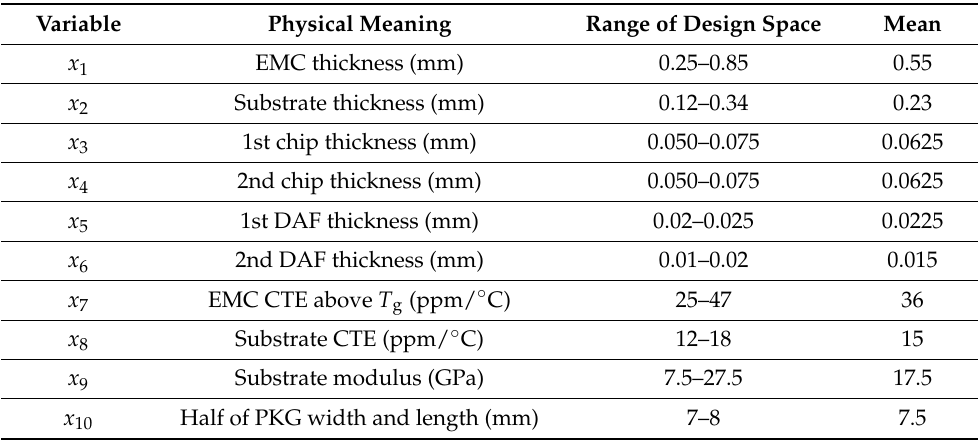
Table 3. Design variables of the TFBGA